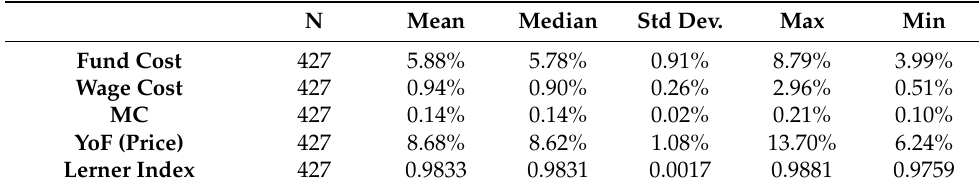
Table 1. Descriptive statistics of the Lerner index and its estimating variables.